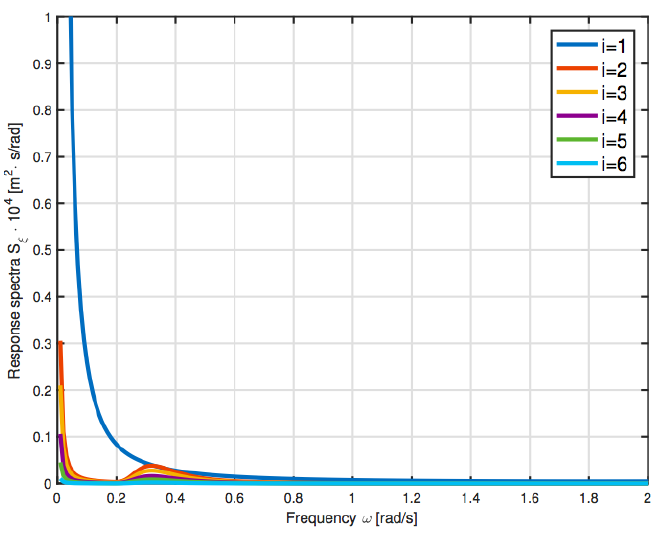
Figure 17. Response spectra for the displacements in physical coordinates of the offshore wind turbine crown pile